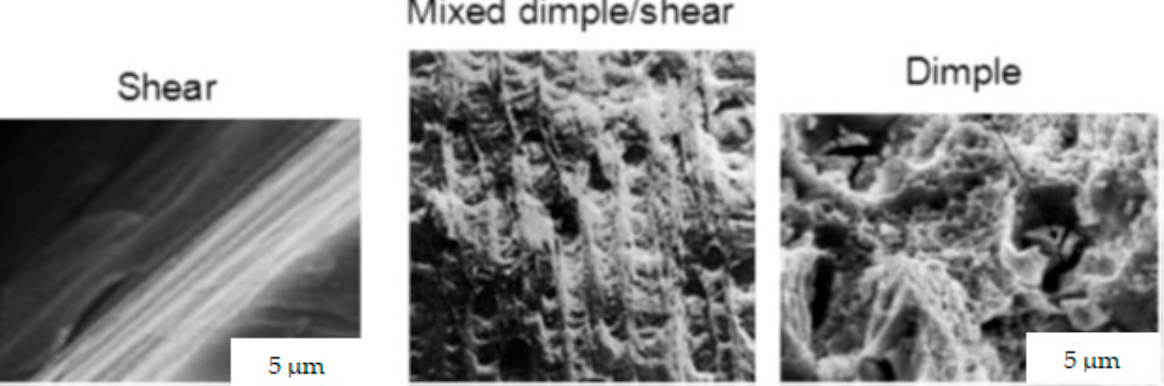
Figure 1. Different types of fracture mechanisms controlled by shear stress and normal stress and their combinations [5].